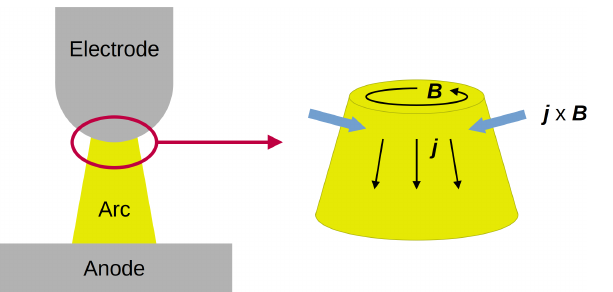
Figure 2. Schematic diagram of a DC plasma arc system, showing orientation of the j , B and j × B vector